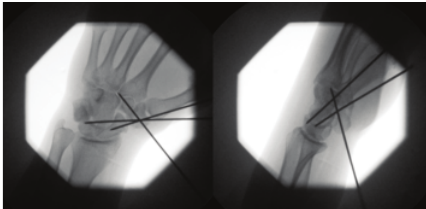
Figure 2: Intraoperative radiographs.